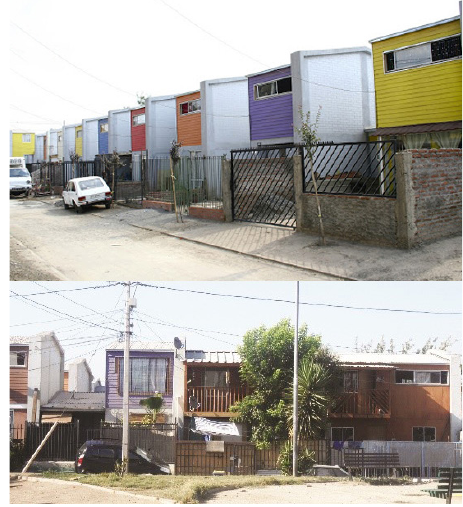
Figure 4. Las Higueras: (above) before extension of houses, 2006 (source: Viviana Peláez, Villa en el sector Los Microbuseros, Peñalolén, January 2007, La Cámara Chilena de la Construcción); (below) after extension of houses, 2015